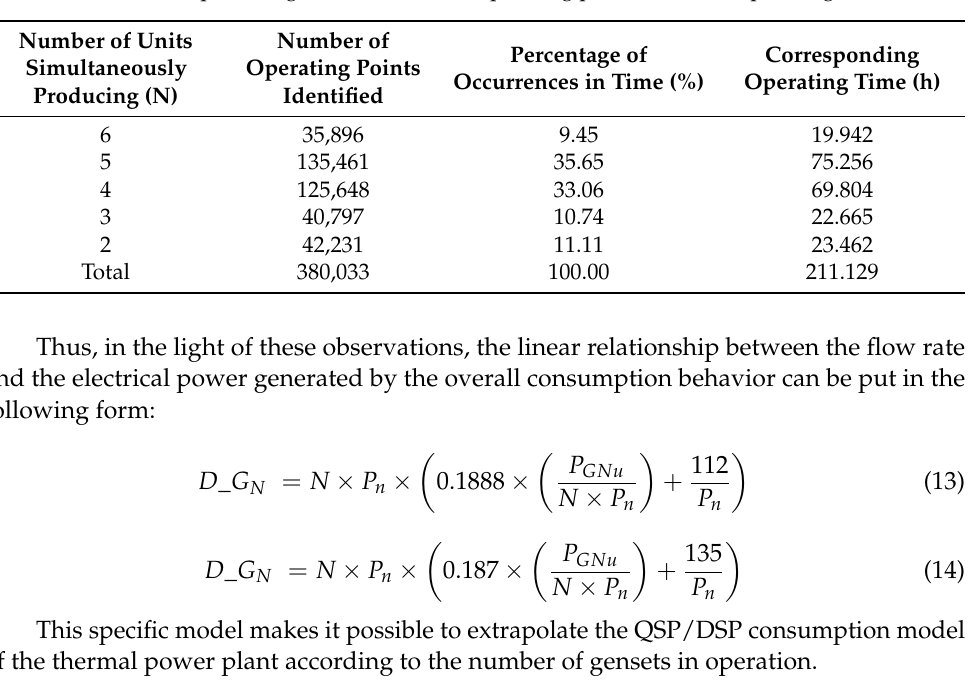
Table 4. Number and percentage of occurrence of operating points and corresponding total